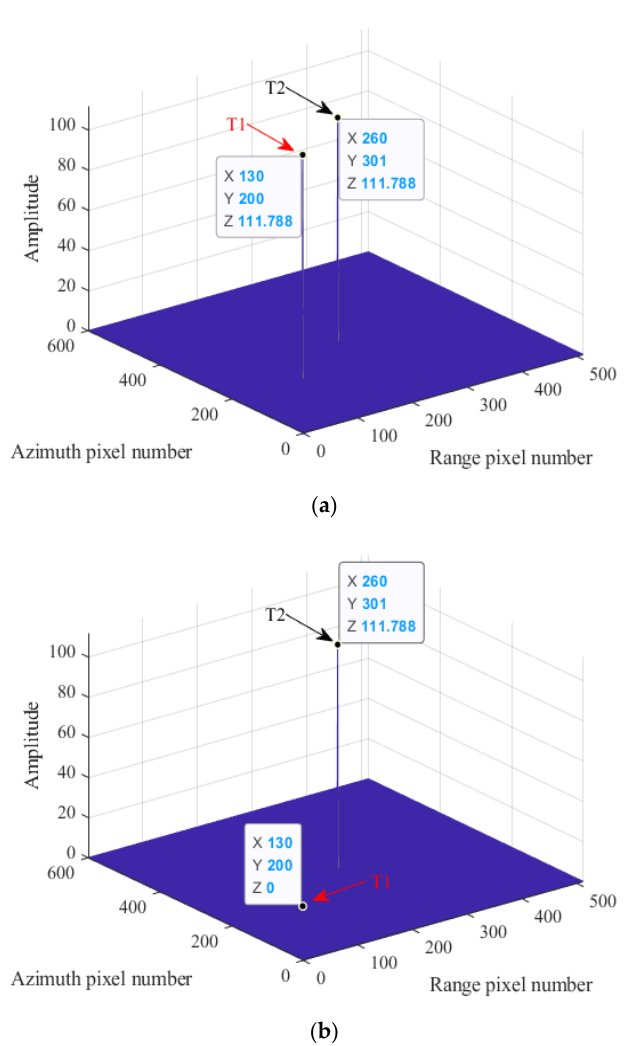
Figure 12. Point target experiment results. ( a ) SAR imaging result of the classical BPA. ( b ) SAR imaging result of the proposed Topo-BPA.